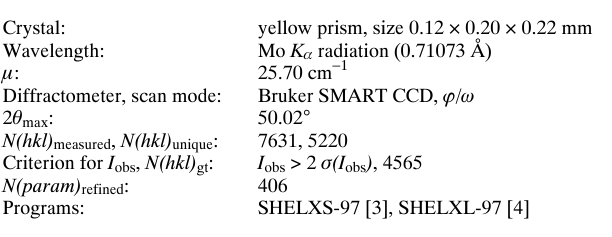
Table 1. D a t a collection a nd h a ndling.